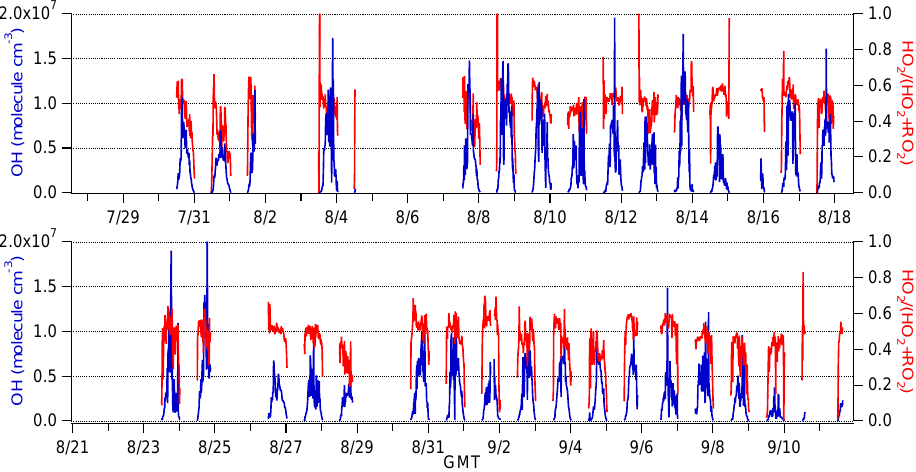
Fig. 7. OH and HO 2 /( HO 2 + ΣRO 2 ) calculated with the MCM box-model.